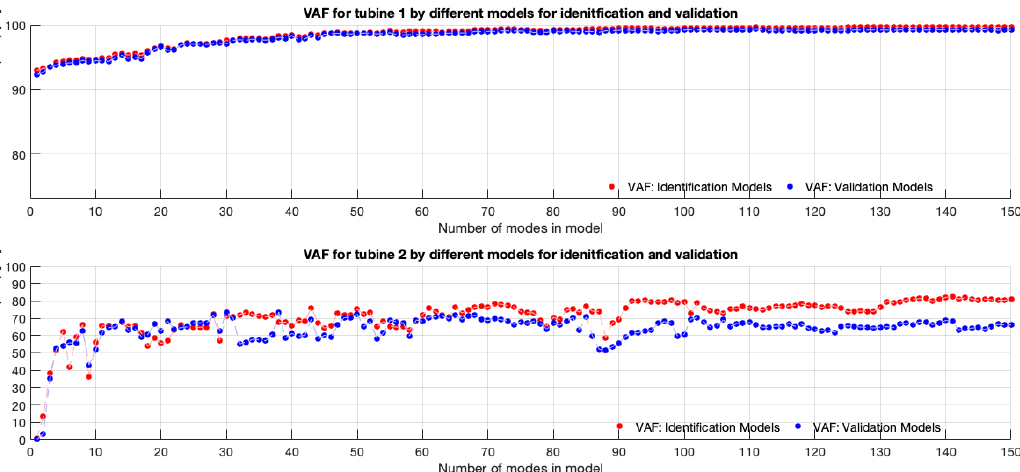
Figure 2. Fit of each model, as measured by VAF. From left to right, each model has increasing number of singular values (also referred to as modes in the context of DMD).